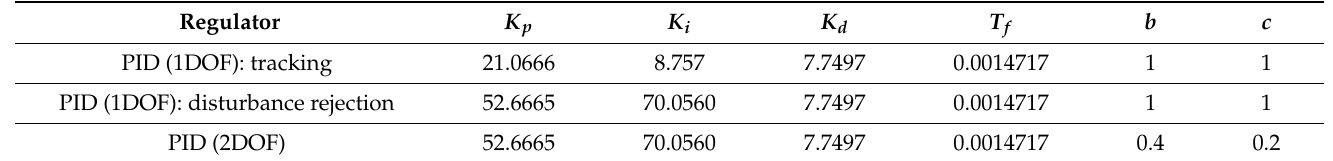
Table 6. Regulator designs leading to the proposed 2DOF control and their corresponding